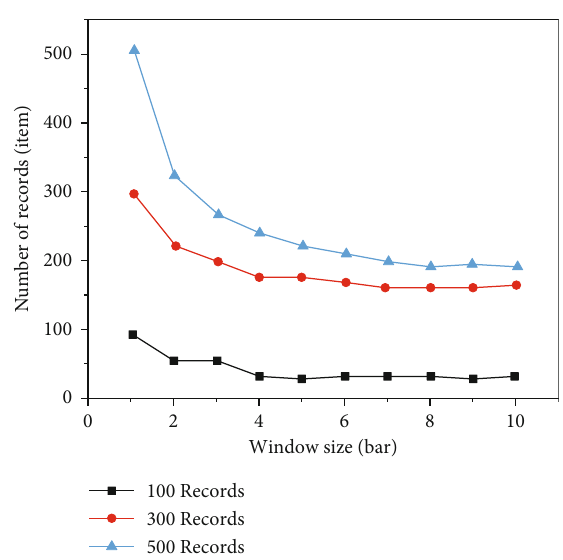
Figure 4: Cleaning results of di ff erent window